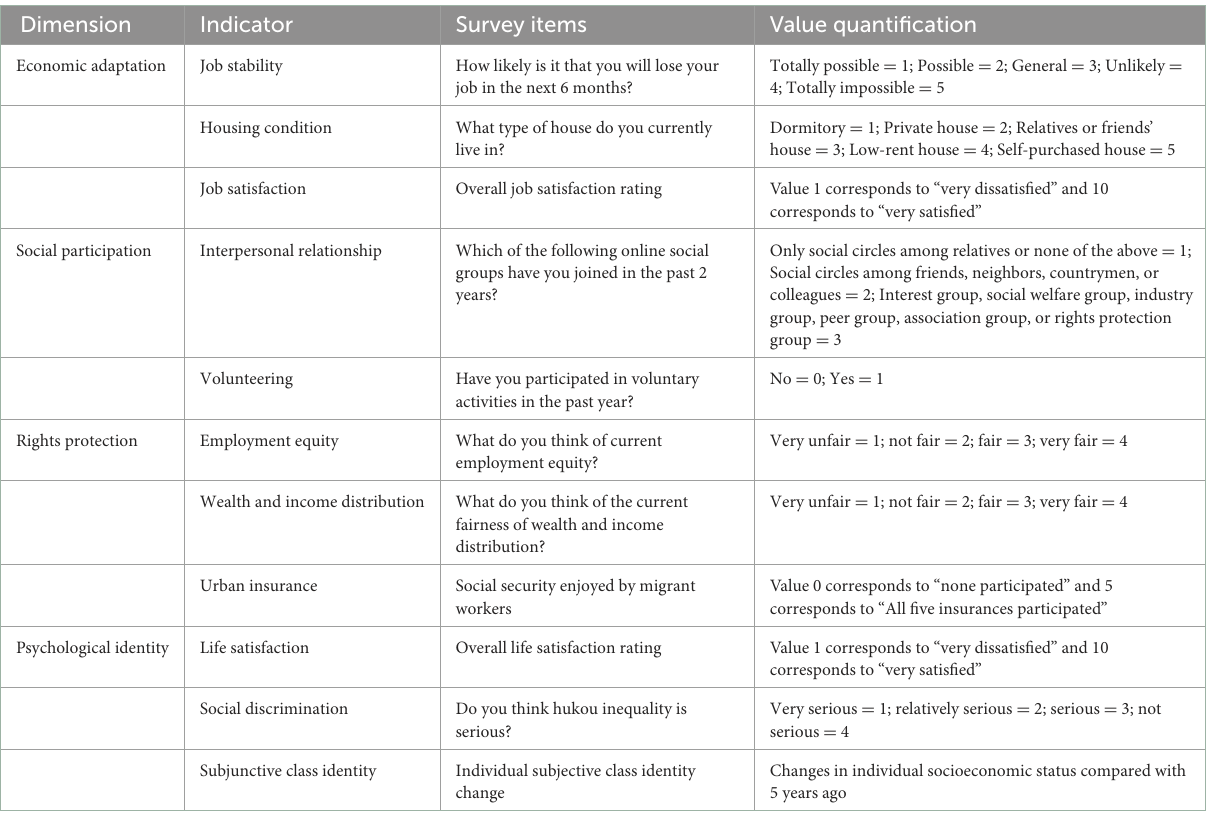
TABLE 1 Migrant workers’ urban integration index